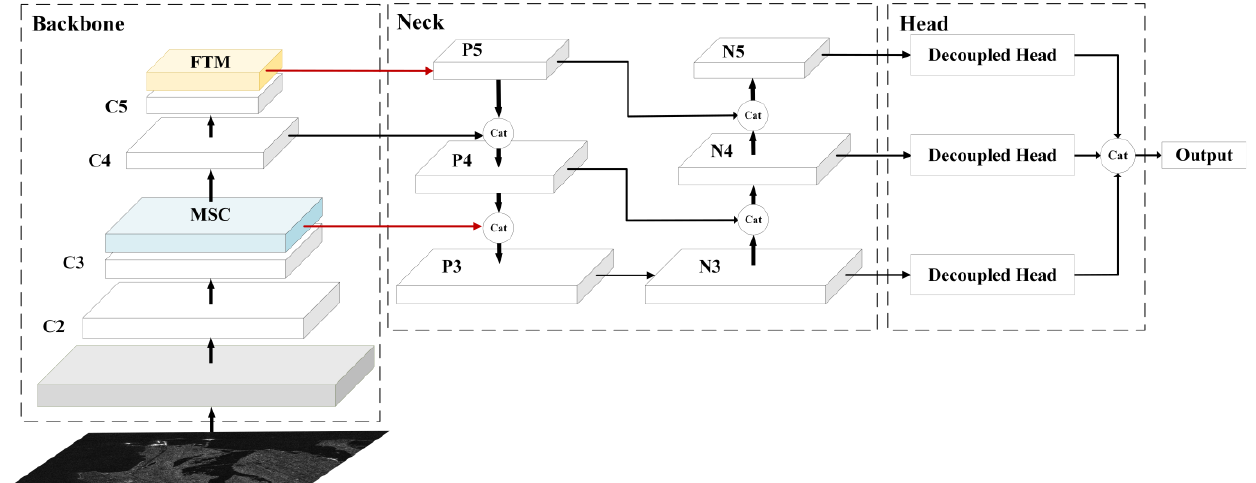
Figure 5. The overall structure of YOLO-SD, where MSC and FTM are added to the backbone, and the connections between the backbone and neck are modified.